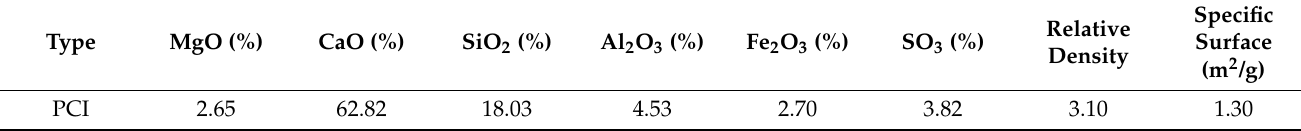
Table 2. Main chemical composition of the binders used for CTB preparation.